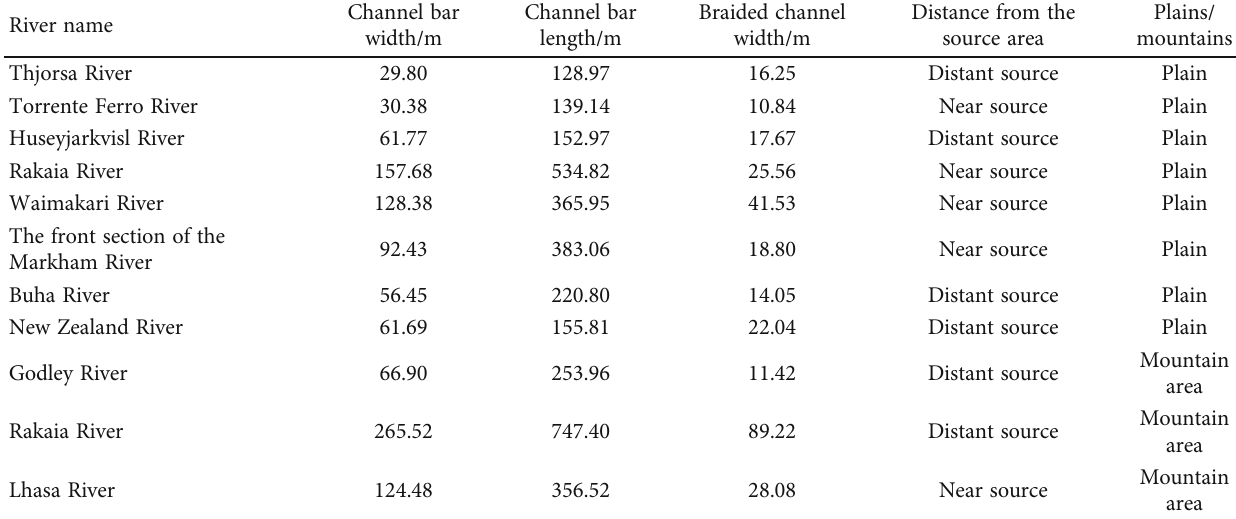
Table 1: Scale measurement results of typical wandering braided. All data are based on measurements taken on Google Earth. River